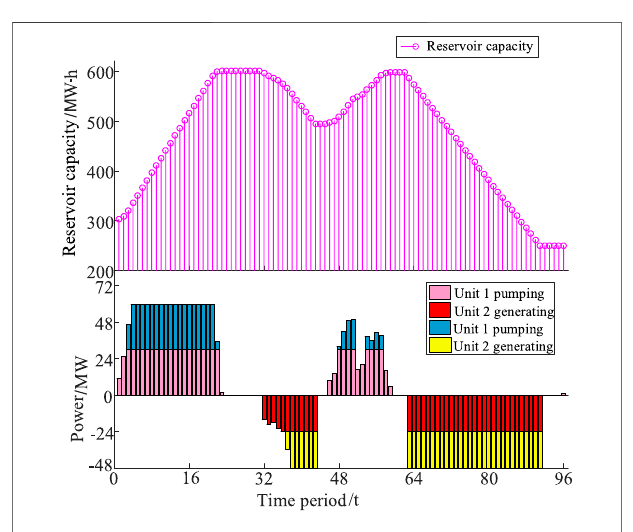
FIGURE 9 | Reservoir capacity and unit output curve of Case 2.